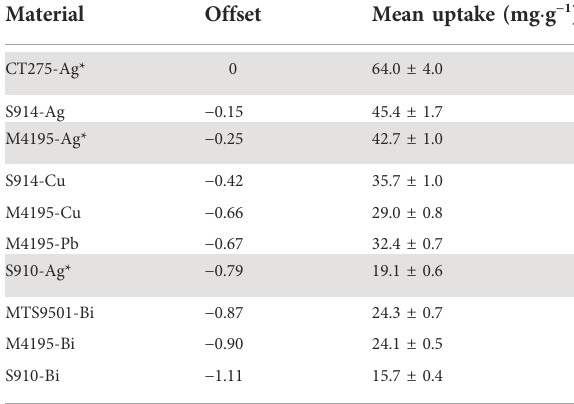
TABLE 3 Showing the discreet variables for which, the data were considered in the construction of the overall group model. Included M4195-Bi, S914-Ag, MTS9501-Bi, S910-Ag, S914-Cu, M4195-Ag,